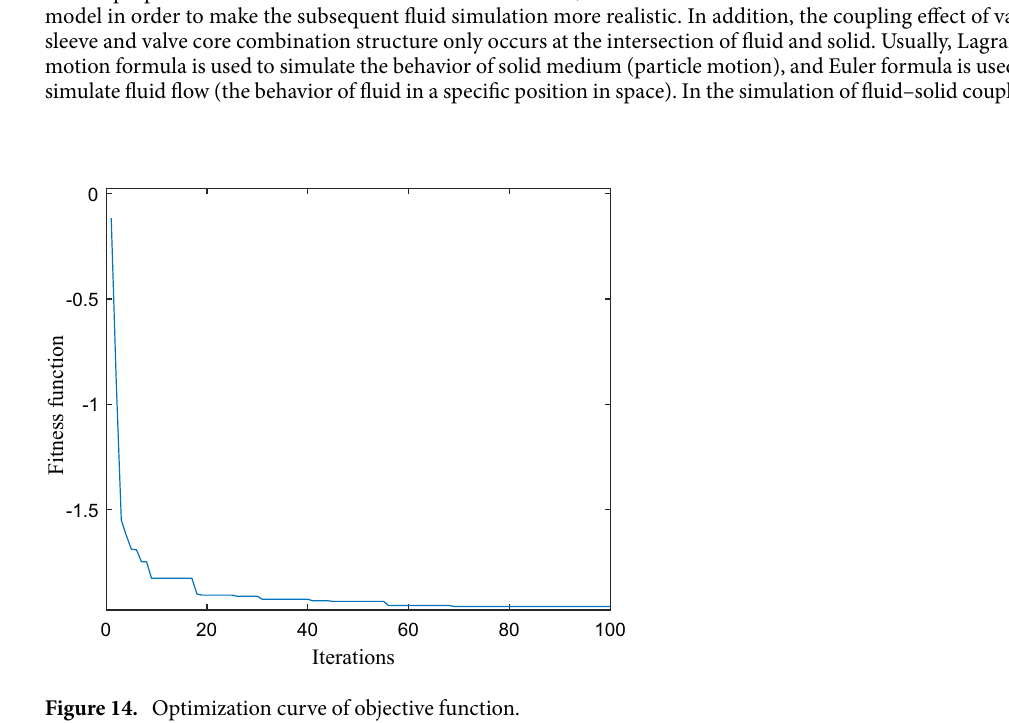
Figure 14. Optimization curve of objective